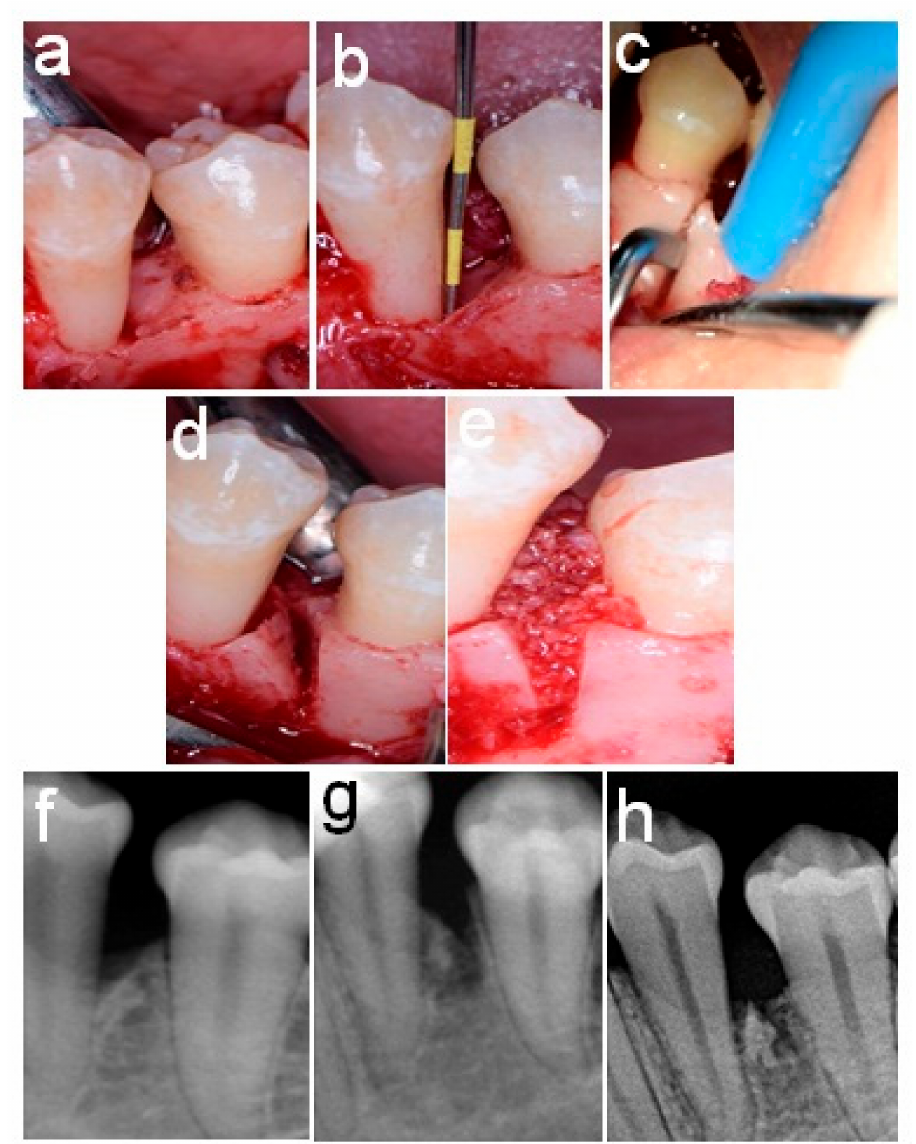
Figure 3. A 6-millimeter-wide two-wall intra-bony defect related to the distal surface of lower-left first premolar of a Group 2 patient. ( a – c ) Osseous wall cutting and tilting ( d , e ) grafting of the V- shaped space, and ( f – h ) intra-oral radiograph obtained before, immediately after, and 6 months after